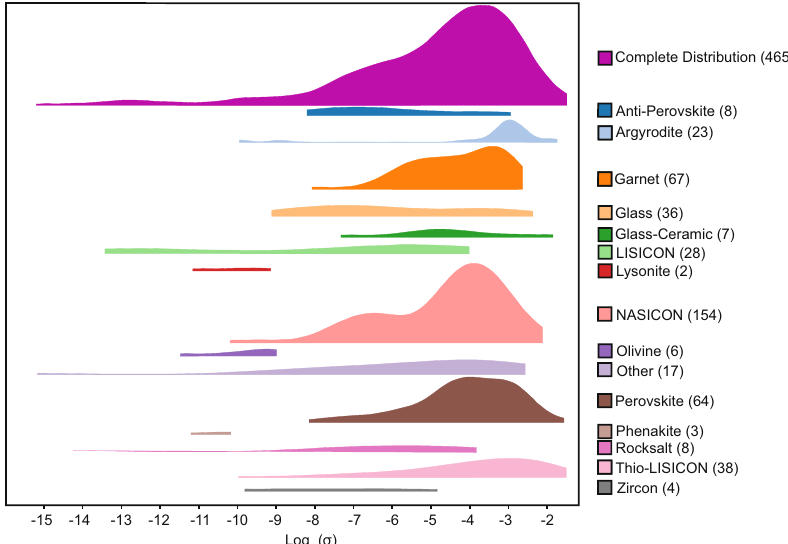
Fig. 2 Distribution of room temperature conductivities across expert-curated structural families. Fitted distribution functions of the room temperature log 10 ( σ ) for all materials within the database separated into expert-curated structural families and scaled by the number of entries within each family, given in brackets. Table 2. Chemistries of the materials in the database of 465 room temperature Li ion conductivities based on anions: pure oxides, oxides containing at least one other anion, pure sul fi des, sul fi des containing at least one other anion, pure halides, and other (which contains materials such as LiBH 4 , Li 3 P, and Li 2 Ca(NH) 2 ). Materials